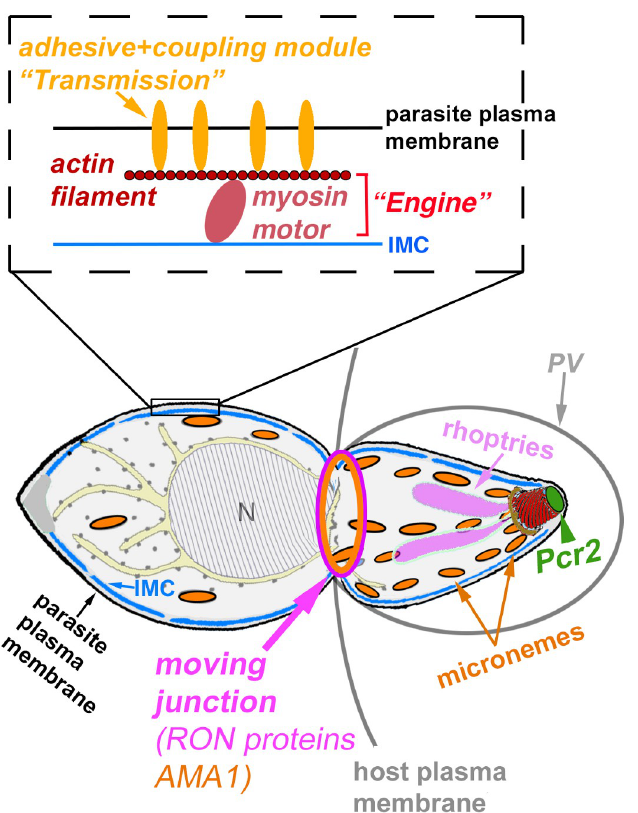
Fig 11. Simplified schematics of an invading parasite with the "engine" and "transmission" modules in the motility apparatus (inset) illustrated. PV: parasitophorous vacuole. N: nucleus. IMC: the Inner Membrane Complex.